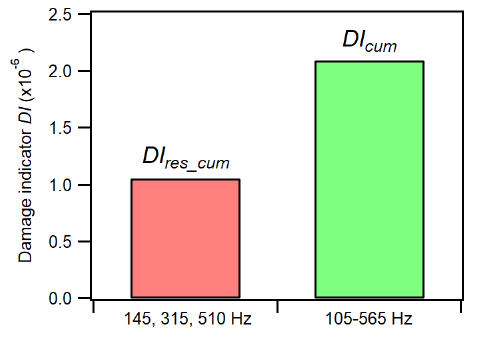
Figure 13. Comparison between the damage parameter DI evaluated as the sum over the three resonance frequencies (red bar) and that obtained as the sum over the three frequency spans.